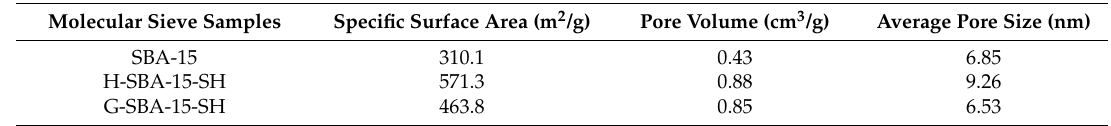
Table 1. Textural properties of mesoporous